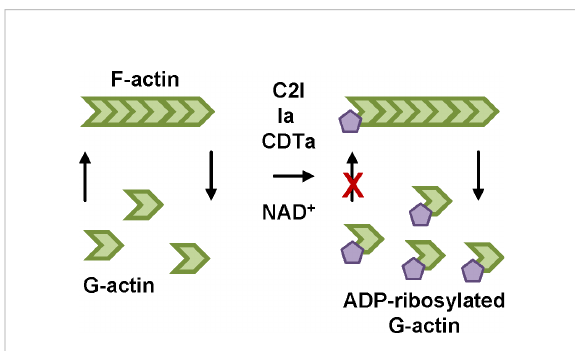
FIGURE 4 ADP-ribosylation of G-actin by clostridial binary leads to depolymerization of F-actin. The enzyme components of C2, iota and CDT toxin, C2I, Ia and CDTa, respectively, covalently transfer an ADP-ribose moiety from their co-substrate NAD + onto their speci fi c substrate monomeric actin (G-actin). If ADP- ribosylated G-actin binds to an actin fi lament (F-actin) no additional G-actin molecule can be attached because of steric hinderance. Due to the dynamic structure of F-actin, the other end of the fi lament continues to depolymerize thereby making more G-actin molecules available for ADP-ribosylation by the toxin enzymes. Therefore, in the end the complete actin cytoskeleton is depolymerized and most of the G-actin is ADP- ribosylated. In adherent cells, this leads to a characteristic cell rounding that is used as a speci fi c and highly sensitive readout for intoxication in cells (Wegner and Aktories,